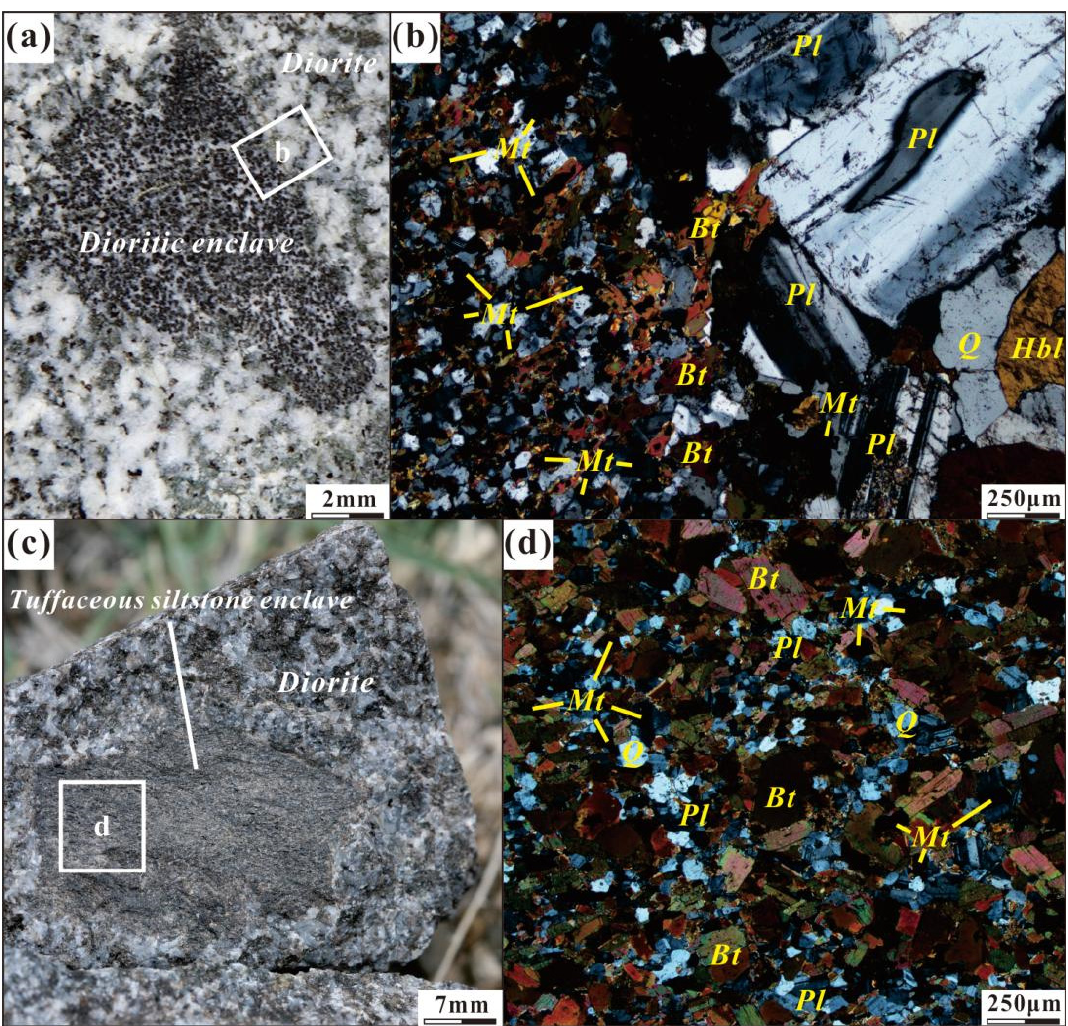
Figure 4. Representative field photographs and micrographs under cross-polarized light of the fine- grained dioritic enclave ( a , b ) and tuffaceous siltstone enclave ( c , d ) hosted in diorite. Abbreviation: Bt: biotite; Hbl: hornblende; Pl: plagioclase; Q: